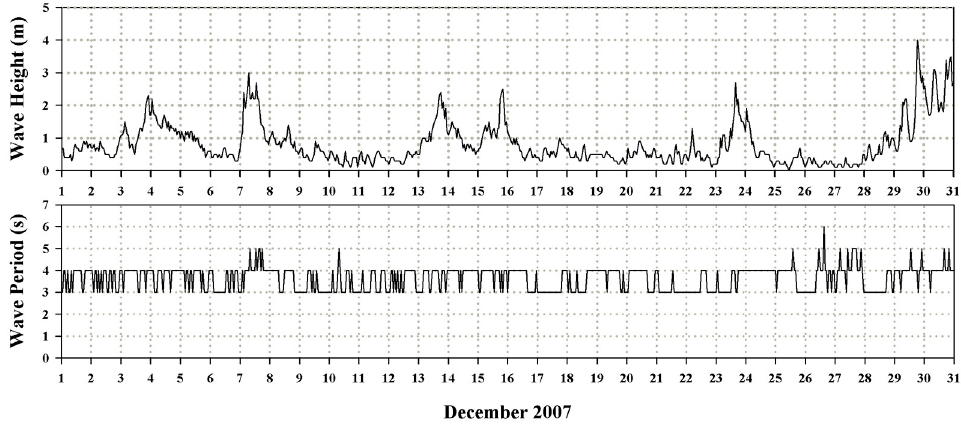
Figure 6. Time series of significant wave height and period observed in Gadaeam buoy.